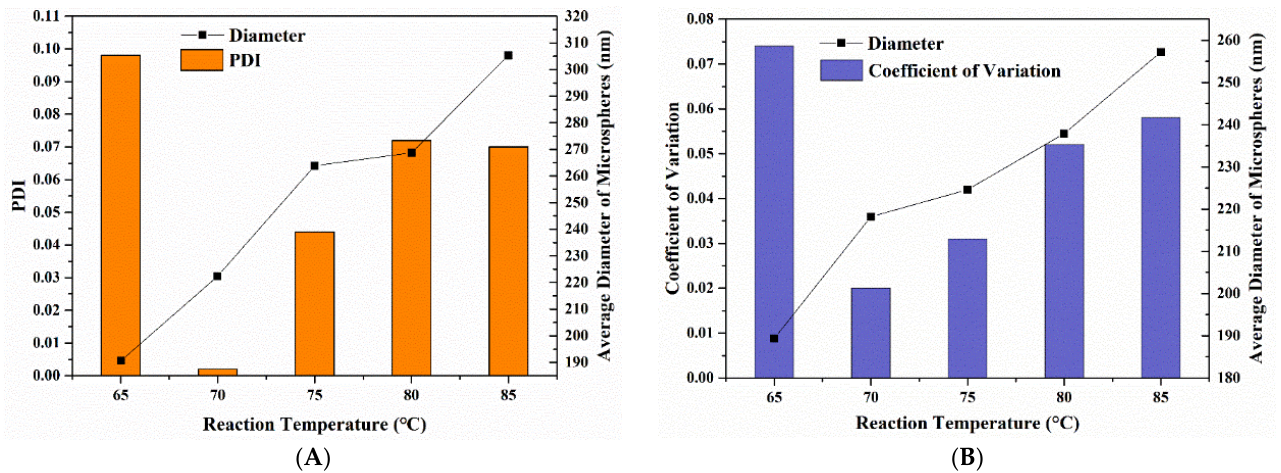
Figure 10. The particle size analysis of P(St-AA) colloidal microspheres synthesized with different reaction temperatures: ( A ) by DLS characterization; ( B ) by measuring FE-SEM images.